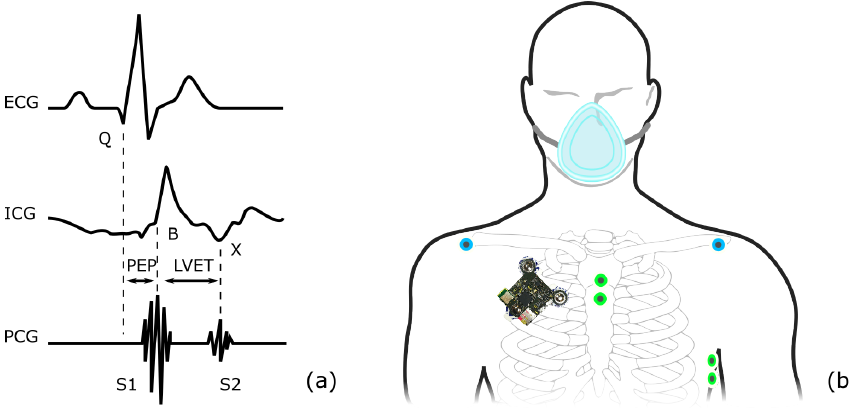
Figure 3. ( a ) PEP and LVET definitions. ( b ) Sensor placement throughout the